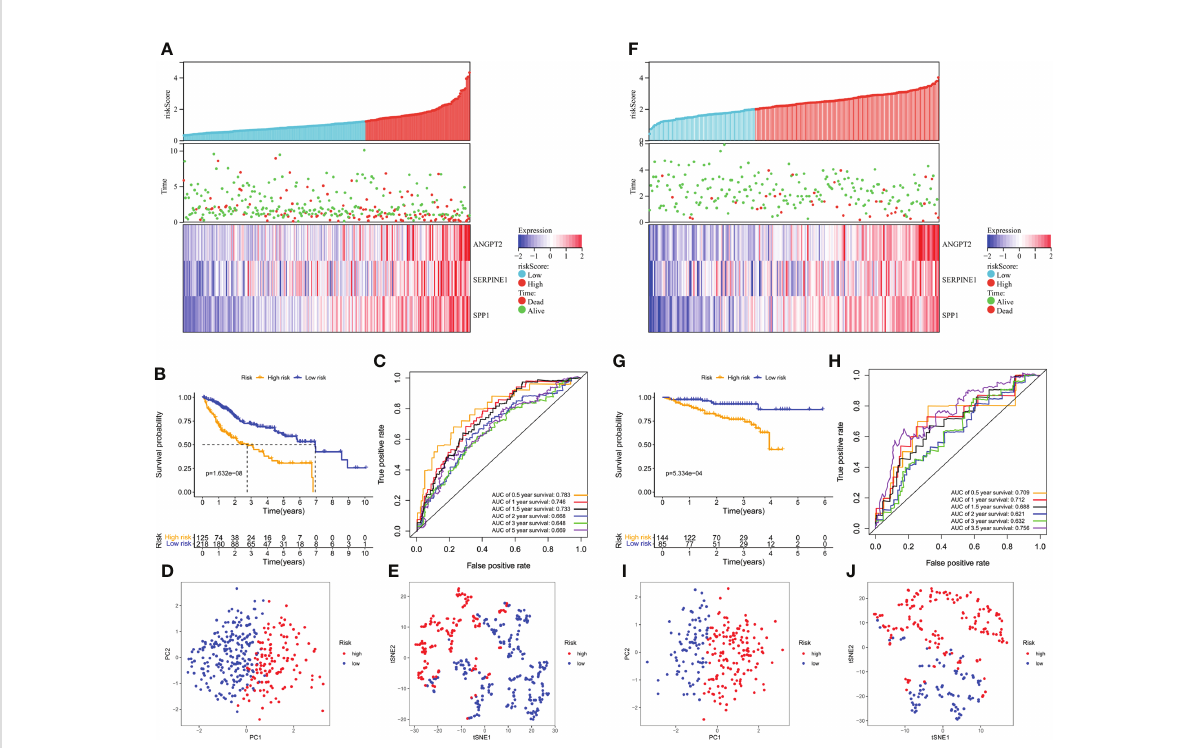
FIGURE 4 Survival analysis of HCC patients in the TCGA training and ICGC validation datasets. (A, B) Risk score distribution, survival status, and heatmap of the expression of the three HRAGs in the high- and low-risk groups in the training and validation cohorts. (B, G) Kaplan-Meier OS curve. (C, H) AUCs of time-dependent ROC curves. PCA (D, I) and t-SNE (E, J) analysis con fi rmed the clustering of the three genes comprising the HRAG signature. (A – E) TCGA cohort; (F – J) ICGC